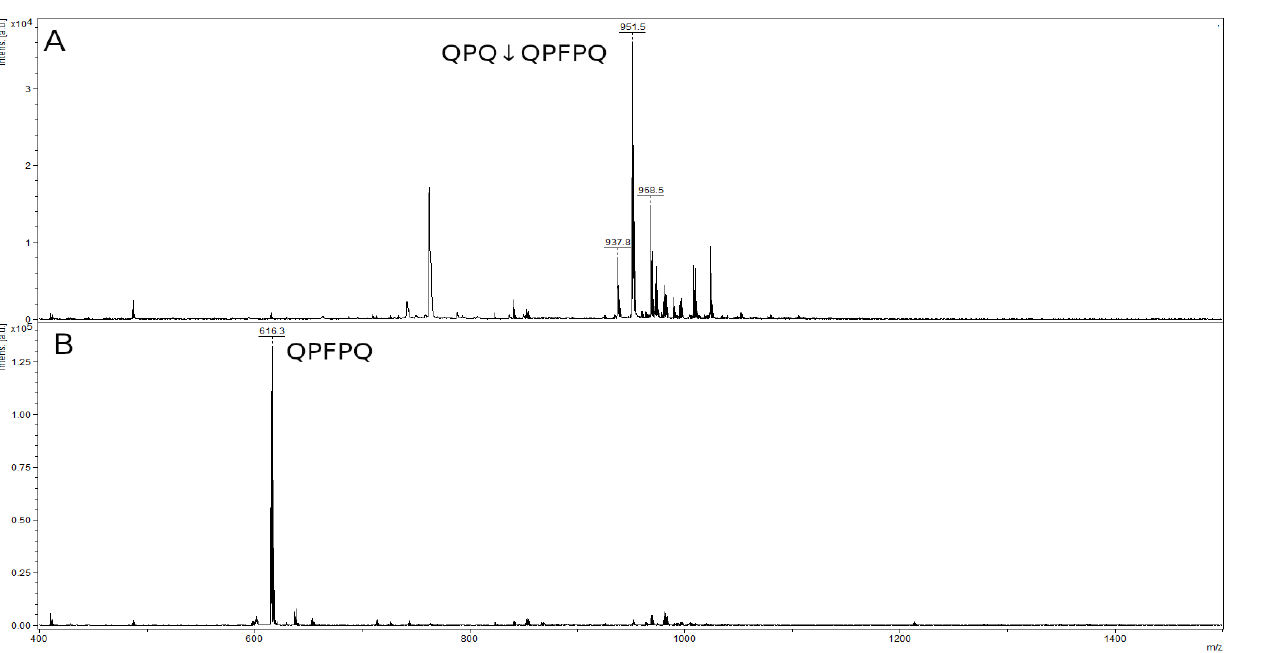
Figure 10. Mass spectra of the original 10-mer LPYPQPQLPQ peptide ( A ) and hydrolysate by rTcCathL1 after 40 min of incubation ( B ).